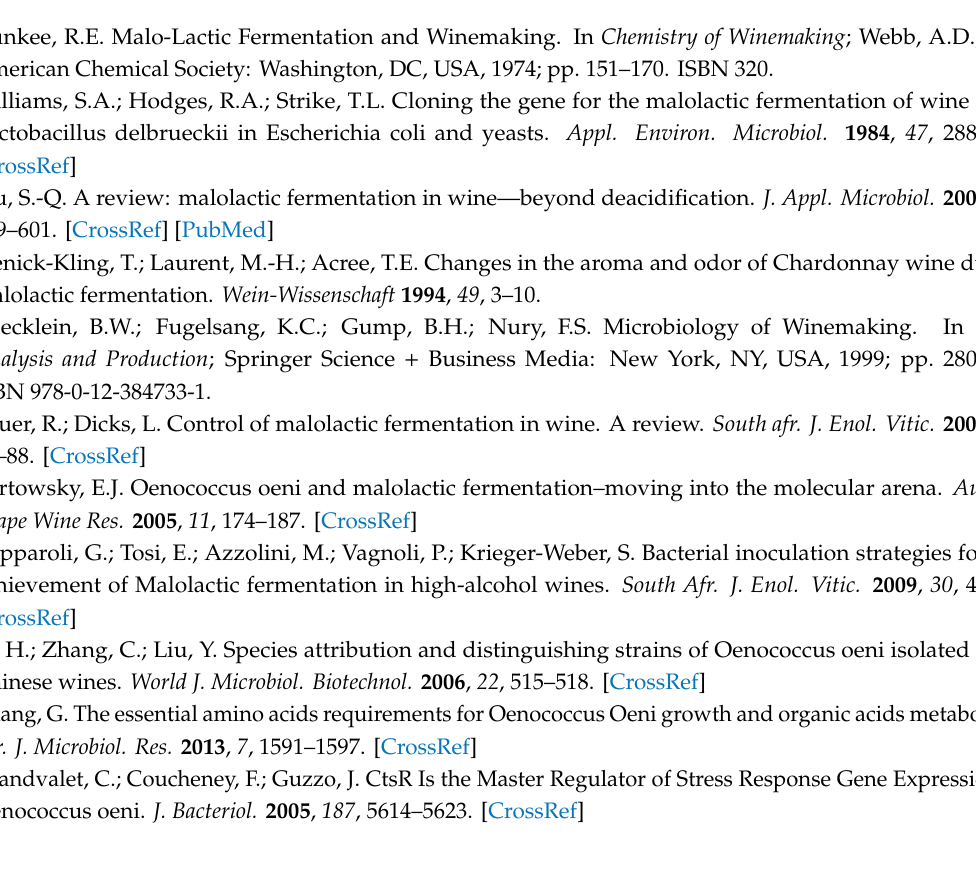
Supplementary Materials: The following are available online. Figure S1: (A) RMSD values show the conformational stability of MLE; (B) Conformational changes of MLE with the corresponding RMSF values. Figure S2: Interactions and contacts of MLE with MAL − (A) and MAL 2 − (B). The total number of interactions is depicted on the upper panels, while bottom panels show residues that interact with the ligand in each trajectory frame. Figure S3: The map of pET21a-MLE expression vector. The purple solid arrow indicates the site of MLE gene of O. oeni strain DSM 20255 (OE